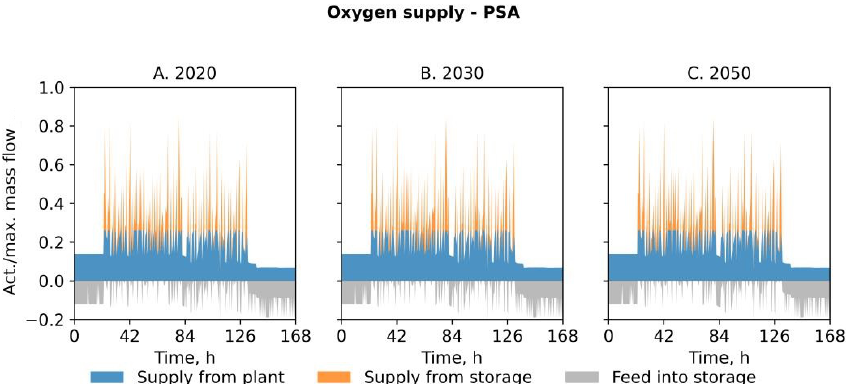
from the storage, and refills it during periods of lower prices. Therefore, the increase in elec-